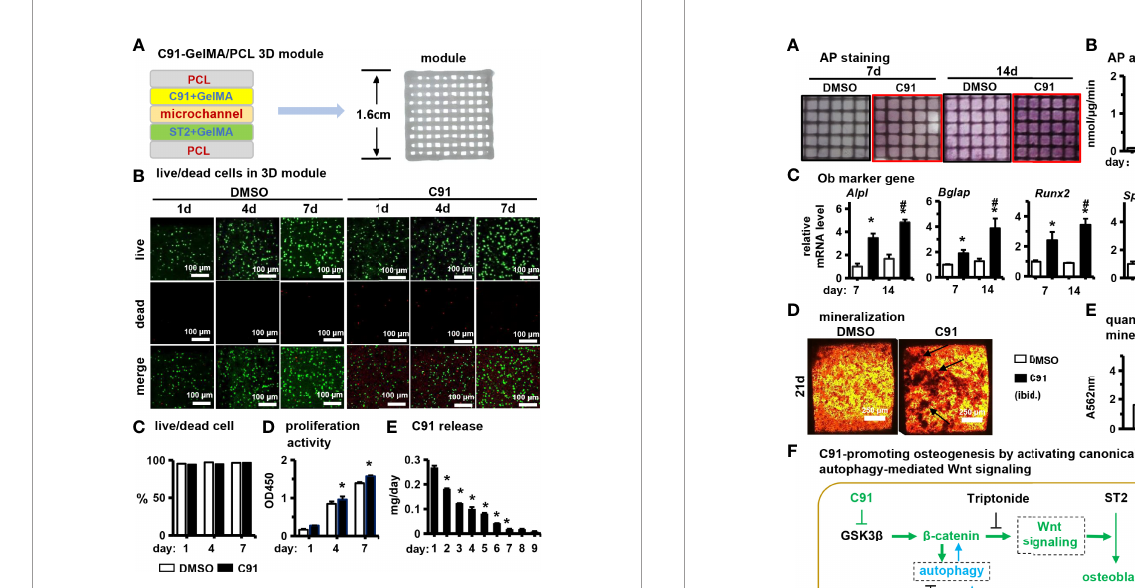
FIGURE 7 | Effects of C91 on ST2 cell growth and proliferation in 3D modules. (A) Schematic diagram of a PCI3D system design (left) and its printing module image (right). The C91-loaded hydrogel bundles, the ST2- loaded hydrogel bundles, and the PCL bundles were printed with each other to form one layer, and 4 layers were continuously printed to form a 3D module. (B) Live/dead cell staining was used to detect the survival and proliferation of cells 1, 4, and 7 days after in vitro culture. Live cells show calcein-am positive (green) and dead cells show EthD-1 negativity (red). Scale bar = 100 m m. (C) Live/dead cell ratios were analyzed using confocal microscopy imaging. (D) The effect of C91 in the CCK8 detection module on the proliferation activity of ST2 cells. Results are expressed as relative OD450 values, calculated by normalizing OD450 readings to the mean value of the control group. (E) The daily sustained release of C91 in the 3D module was detected using a drug release assay. * indicates P < 0.05, compared with the DMSO group.